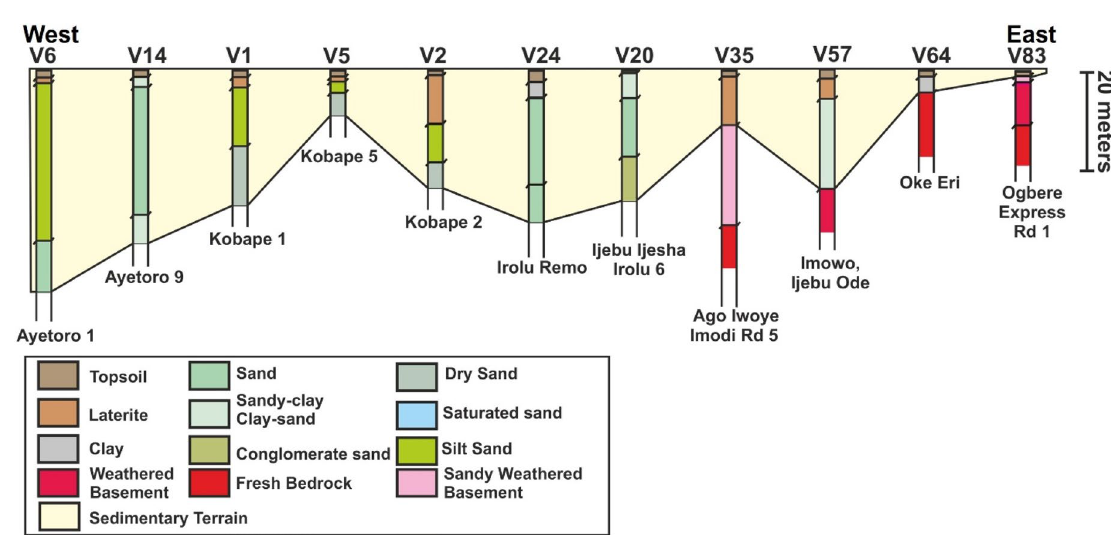
Figure 8. Regional VES profile 3 from Ijari-Ilese through Ogbere to Ode Rele showing how the basement complex is onlapped on the west and the east by sedimentary rock. The location of the VES transect is shown in Fig.